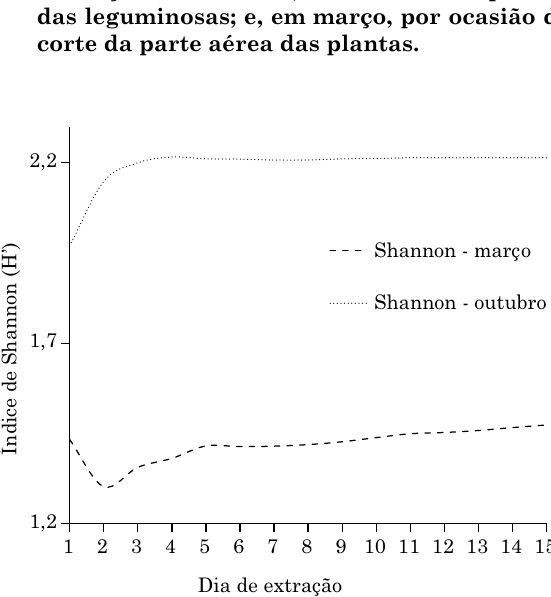
Figura 2. Variação diária do índice de Shannon (H’), por causa da quantidade de organismos capturados, discriminada por época de avaliação: em outubro, um dia antes do plantio das leguminosas; e, em março, por ocasião do corte da parte aérea das